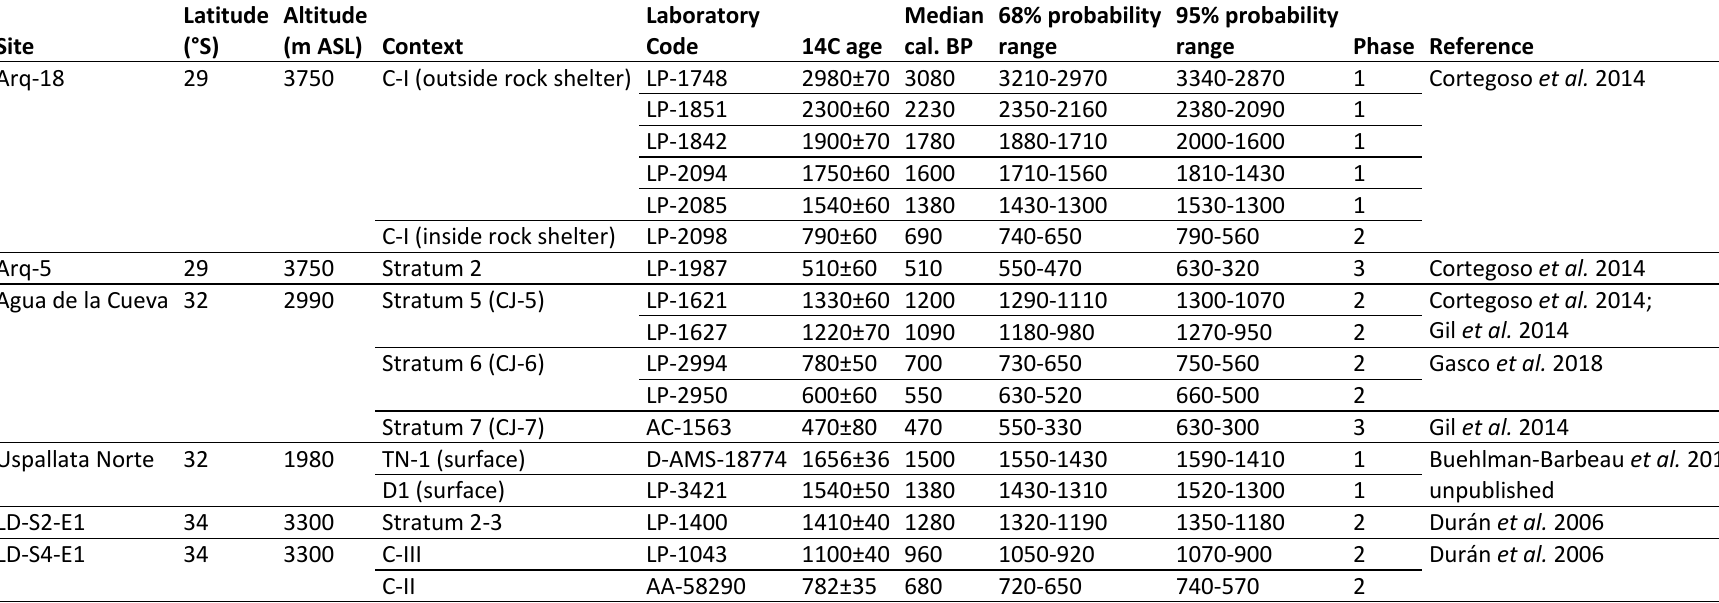
Table 1. Archaeological sites, dates, and phases associated with projectile points. Dates calibrated with SHCal13 (Hogg et al. 2013) and rounded by 10 years. In the text, we refer to calibrated medians but do not disregard the error